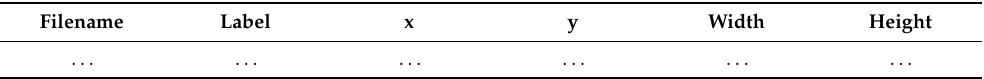
Figure 5. Specimen Grid and file name convention for Test 1 ( a ) and Test 2 ( b ).